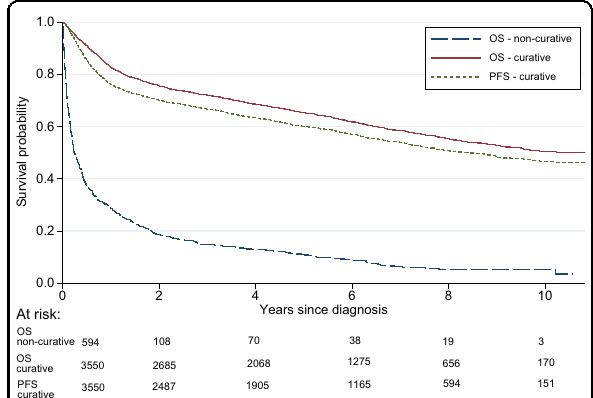
Fig. 1 Overall survival and progression-free survival. Overall survival (OS) among curatively ( n = 3550) and non-curatively ( n = 594) treated diffuse large B-cell lymphoma (DLBCL) patients diagnosed 2007 – 2014 in Sweden, and progression-free survival (PFS) among curatively treated